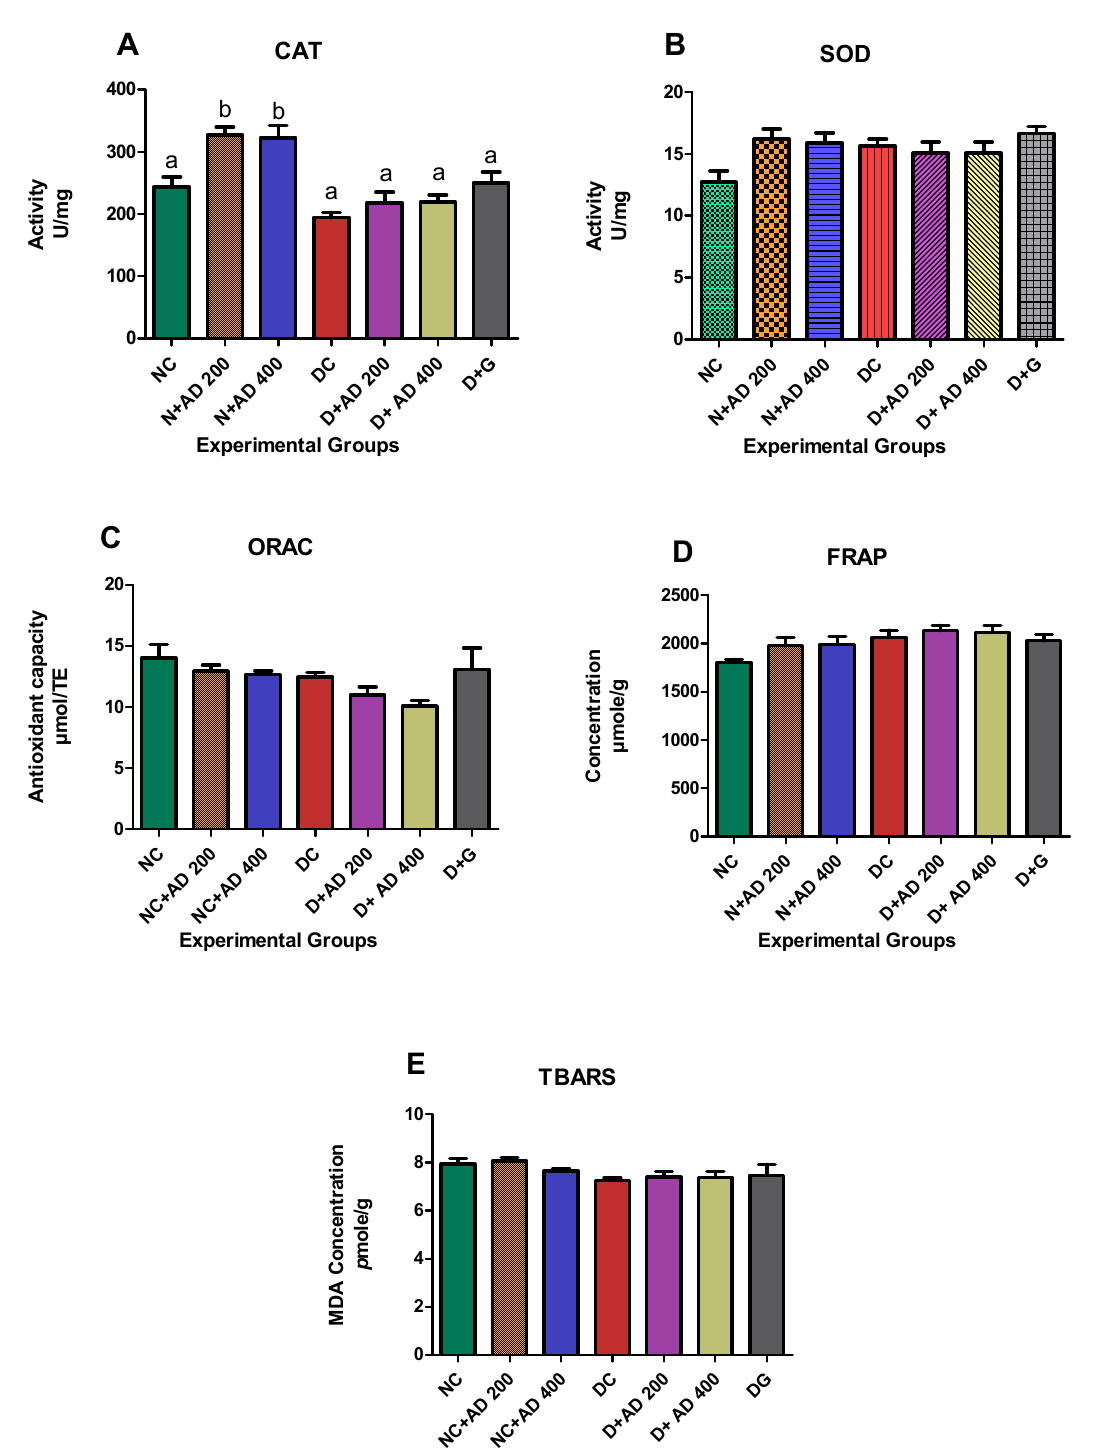
Figure 4. Effect of intervention with AD on the antioxidant capacities; ( A ) CAT, ( B ) SOD, ( C ) ORAC ( D ) FRAP and ( E ) Lipid peroxidation in the kidney of normal and diabetic rats (TBARS). Bars are indicative of mean values ± SEM of group values. Bars with different letters are significantly ( p < 0.05) different from each other.